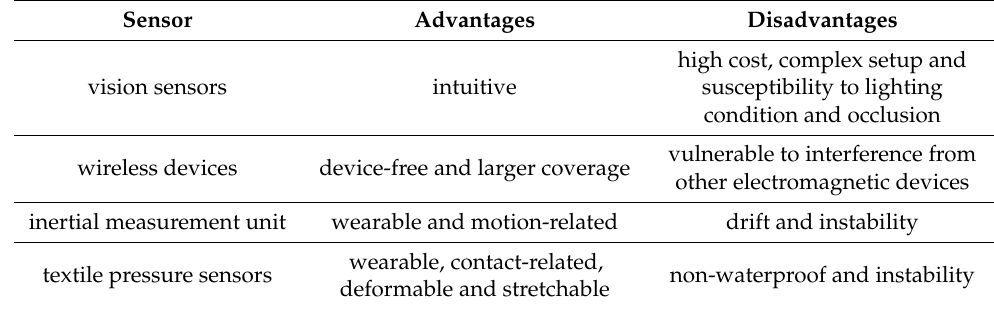
Table 2. Advantages and disadvantages of some commonly used sensors for